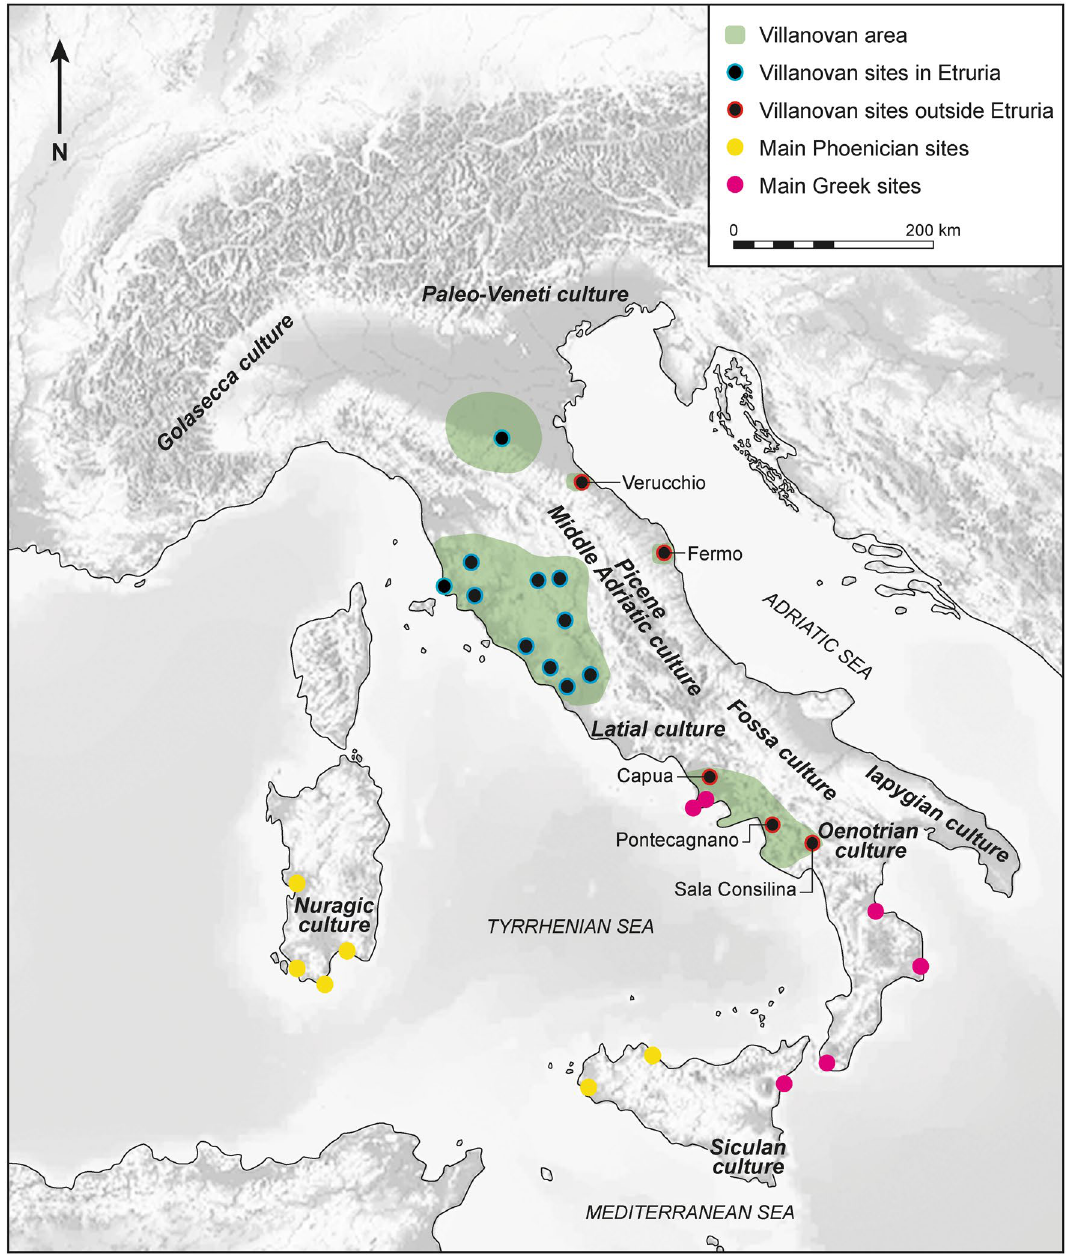
Figure 1. Italy during the Early Iron Age (tenth–eighth century BCE). Diverse cultural groups are archaeologically identified in the Italian Peninsula, Sicily and Sardinia. Green area: Villanovan areas; black dot with blue border: some of the main Villanovan sites; black dot with red border: Villanovan sites outside Etruria; pink dot: some of the main Greek sites; yellow dot: some of the main Phoenician sites. The open access map was downloaded from (https:// pixab ay. com/ illus trati ons/ italy- alps- alpine- region- map- 18048 93/) and modified in Adobe Illustrator 2023 27.1.1 (Adobe